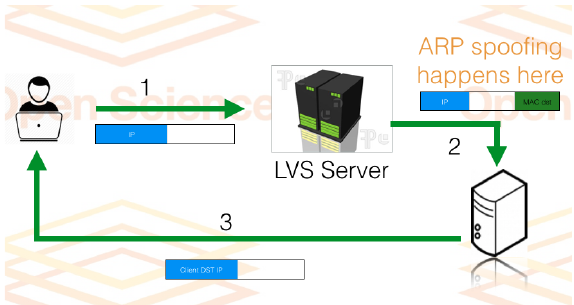
Figure 1. Diagram of LVS spoofing for